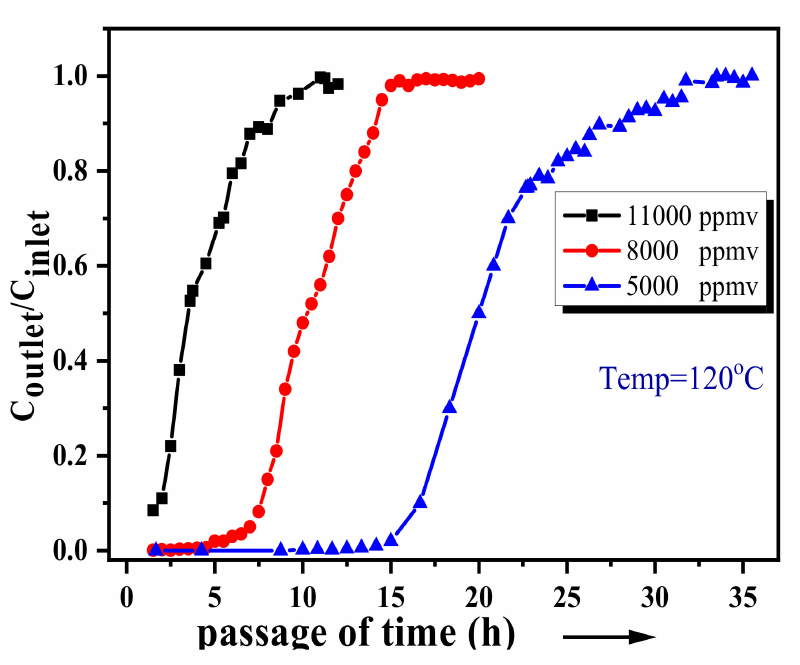
Figure 7. Experimental breakthrough curves at different CB/N 2 inlet concentrations. Experiments conducted at 120 ◦ C, 0.1 g ACF, 100 SCCM gas flow rate, and GHSV = 20,000 h − 1